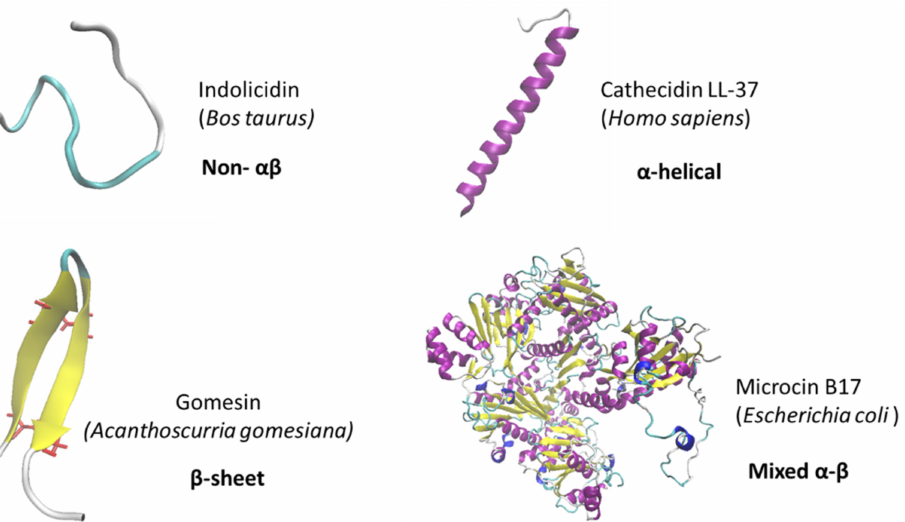
Figure 1. Tridimensional structure of the typical representative of the four groups of AMPs classified according to the presence of α -helix and/or β -sheet secondary elements: non- αβ , α -helical, β -sheet and mixed α - β